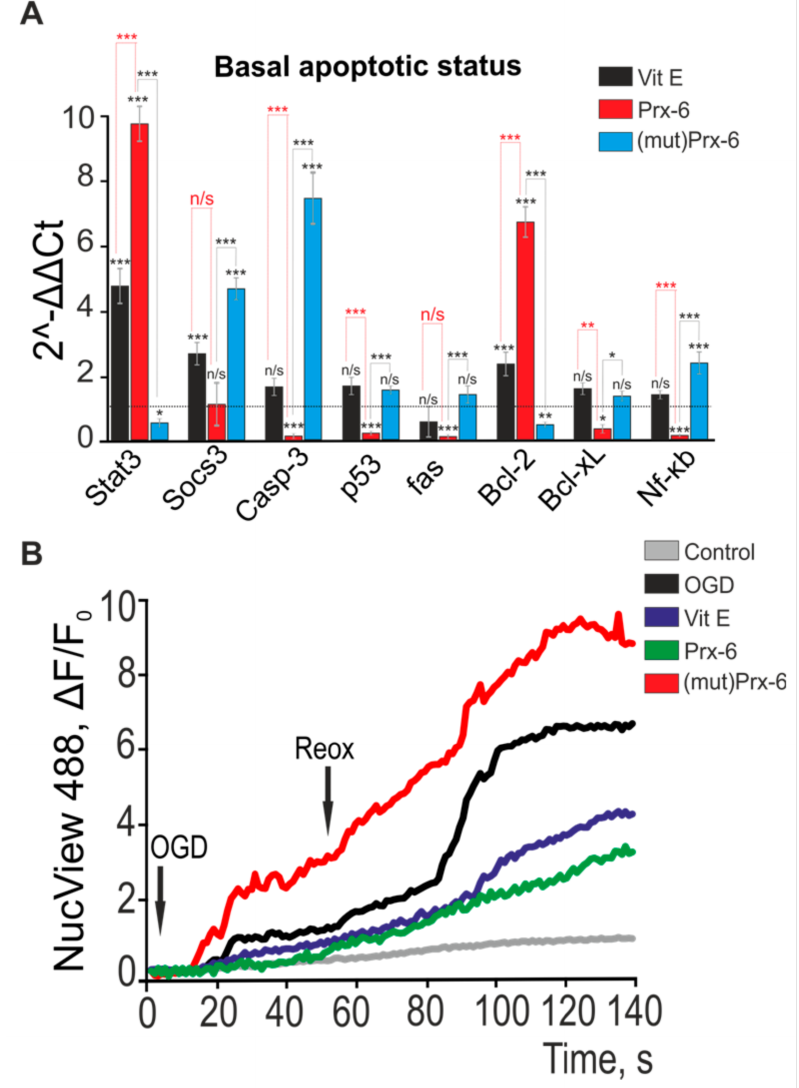
Figure 5. Anti-apoptotic role of 24-h incubation of hippocampal cells with Vit E, Prx-6 and mutPrx-6 under OGD and during reoxygenation. ( A ) Effect of 24-h incubation of hippocampal cells with Vit E (100 µ M), Prx-6 (100 µ M) and mutPrx-6 (100 µ M) on the basal expression of genes involved in regulation of apoptosis. Dashed line level of gene expression in controls (without any effects of the compounds under study). ( B ) Hydrolysis of the fluorogenic substrate of caspase-3 (NucView-488) during a 40-min OGD treatment and the 1.5 h of reoxygenation, indicating apoptosis induction in hippocampal cells. Symbols: Control is the cell culture not exposed to OGD treatment and reoxy- genation; OGD denotes cells which were exposed to OGD conditions (40 min) and reoxygenation (1.5 h); Vit E, Prx-6 and (mut) Prx-6 are cells which were incubated for 24 h with the compounds under study exposed to OGD and reoxygenation. Statistical significance was assessed using paired t -test. n/s—data not significant ( p > 0.05), * p < 0.05, ** p < 0.01 and *** p <